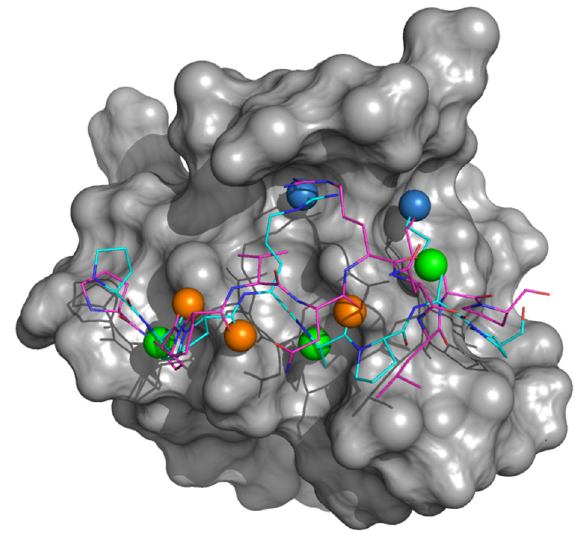
Figure 1. Pharmacophore model for Grb2 C-SH3:Gab2 complex. The Grb2 C-SH3 domain is reported as gray surface. The Gab2 core binding regions are reported as lines, Gab2a PPPRPPKP cyan and Gab2b PPVNRNLKP magenta. The pharmacophore queries are depicted as sphere: green for hydrophobic, orange for H-bond acceptor and light blue for positive charge and H-bond donor.